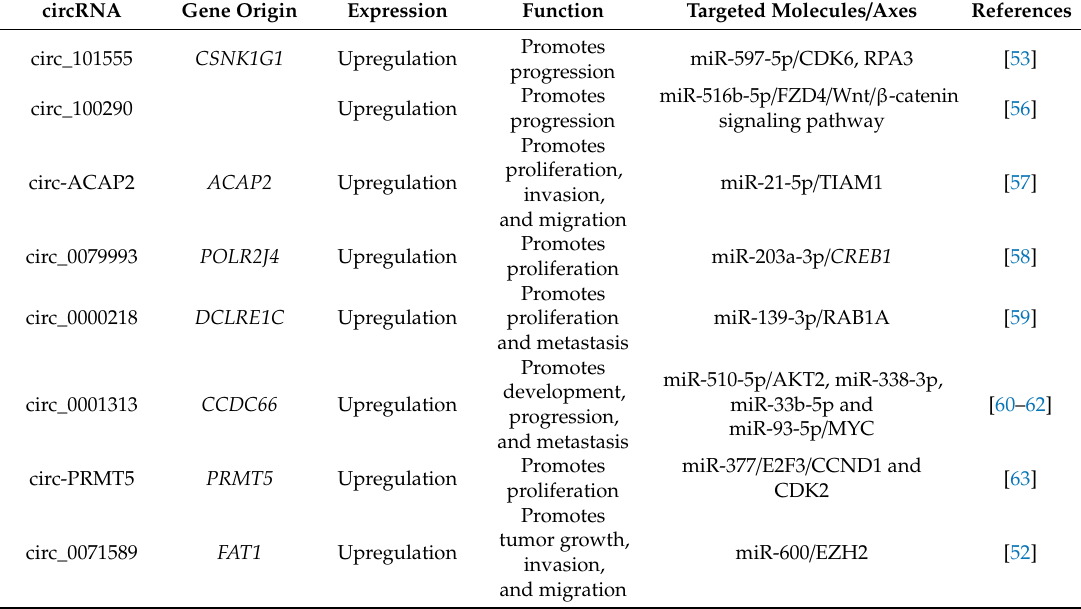
Table 1. circRNAs upregulated or downregulated in CRC, with the implication in CRC progression and